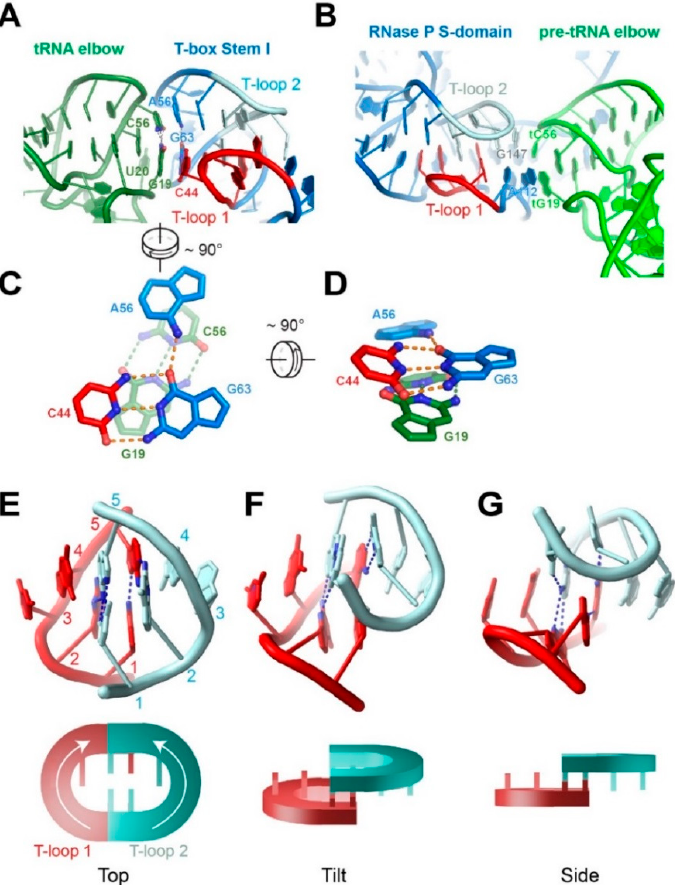
Figure 4. The interdigitated T ‐ loops mediate the recognition of tRNA elbow structure. ( A ) tRNA elbow recognition by the T ‐ box stem I domain (PDB ID: 4LCK) [26]; ( B ) pre ‐ tRNA elbow recognition by the RNase P S domain (PDB: 3Q1Q) [15]; ( C , D ) two orthogonal views from (A), of the stacking interface between the T ‐ box base triple and the tRNA tertiary base pair. Hydrogen bonds are indicated by dashed lines; and ( E – G ) three views of the structure of the interdigitated T ‐ loop motif. Nucleotides of each T ‐ loop are numbered 1–5 in the direction of 5 ʹ to 3 ʹ . Cartoon representations of the motif are shown beneath the structural models.